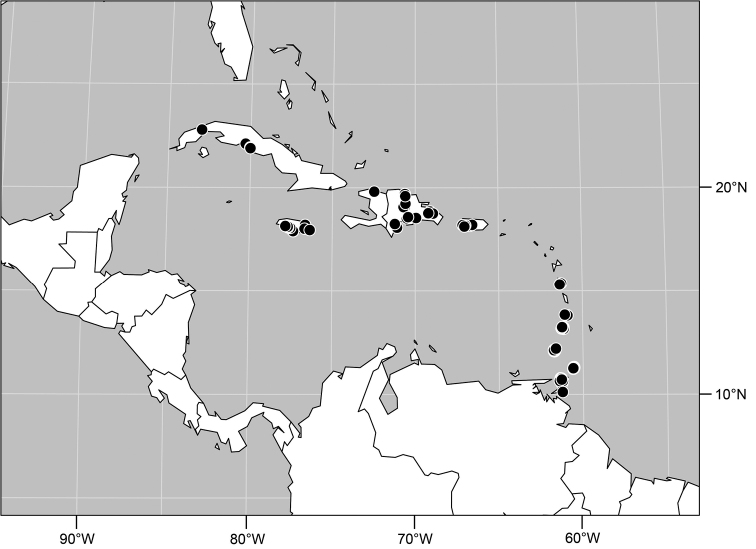
Distribution of Polytrichophora desmata (Williston).